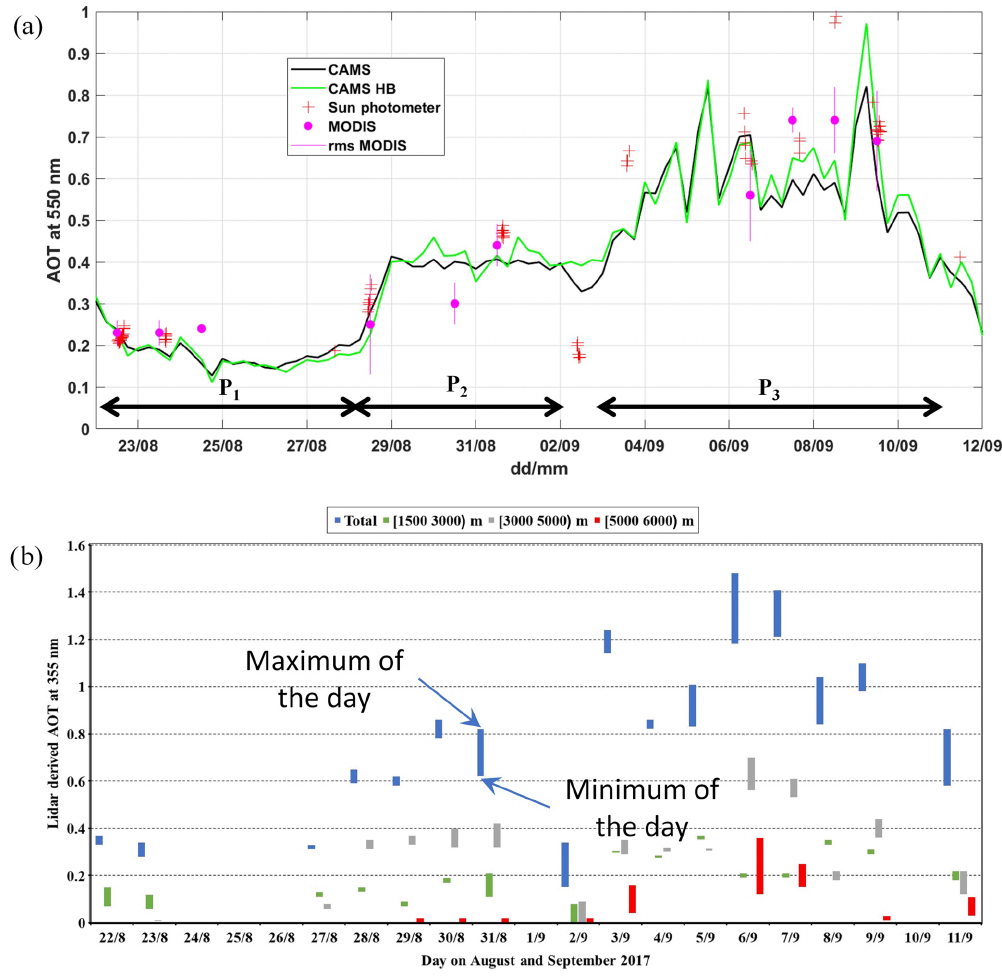
Figure 2. (a) Temporal evolution of the AOT at 550nm derived from CAMS (solid black and green lines), Sun photometer (red crosses) and MODIS (magenta dots) data. The solid green line shows CAMS AOT extracted on the grid cell centred on Henties Bay. The solid black line shows the CAMS AOT averaged over nine grid cells (a 3 × 3 grid box) centred on Henties Bay. The three periods highlighted by the AOT values ( P 1 , P 2 and P 3 ) are indicated. (b) Temporal evolution of the lidar-derived AOT at 355nm for the altitude ranges [1500 3000[m in green, [3000 5000[m in grey and [5000 6000[m in red. The total AOT is given in blue. The vertical bars delimit the daily extremes of